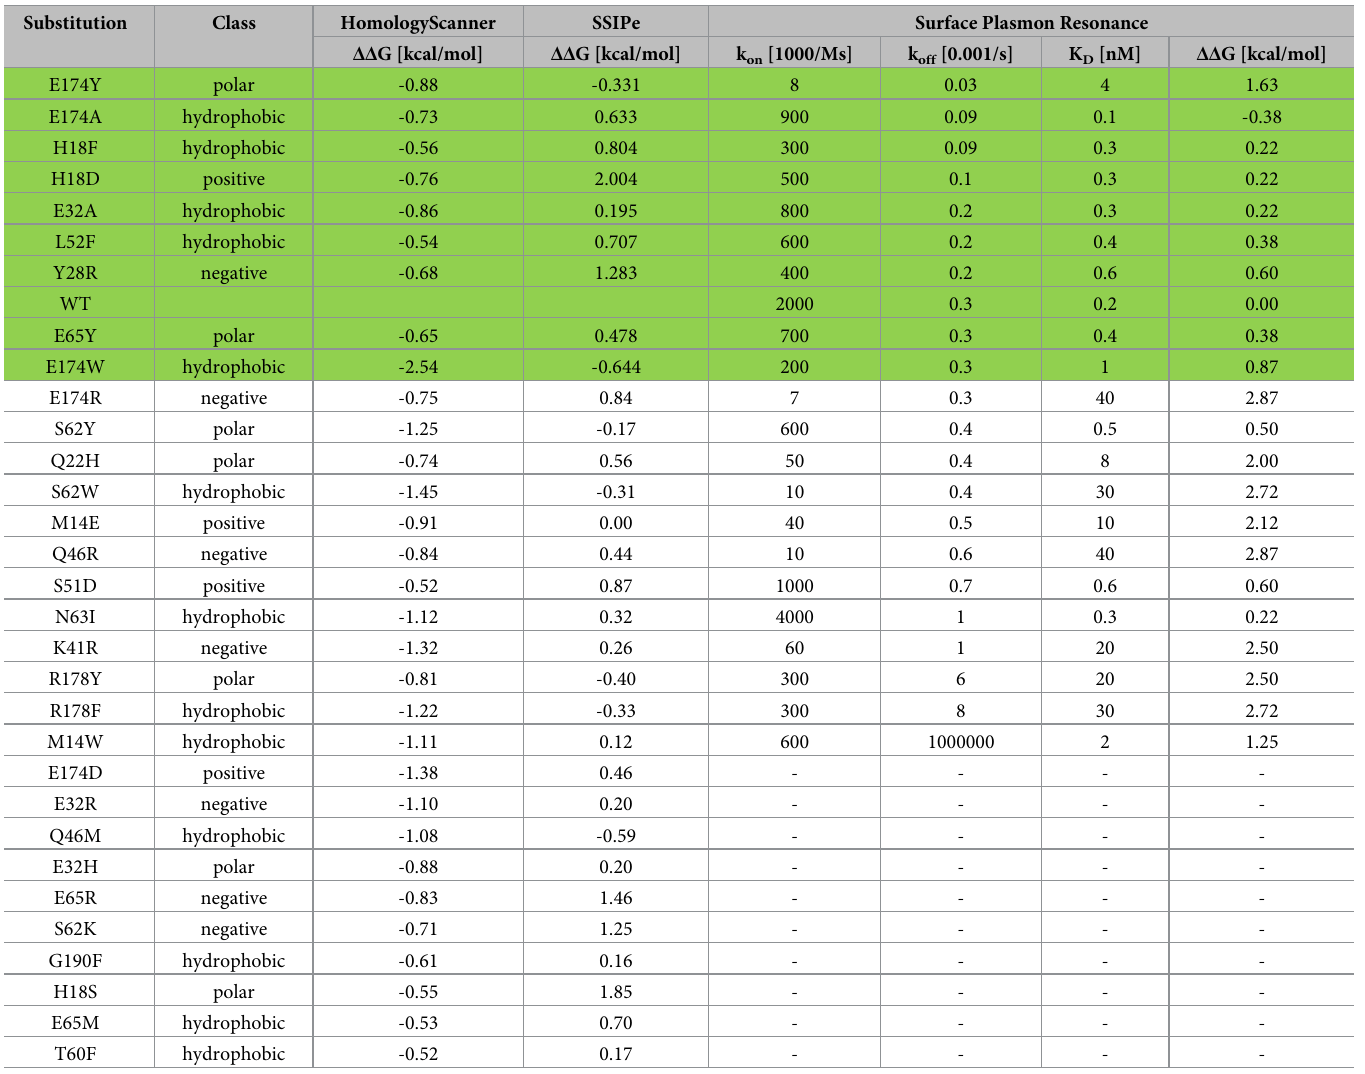
Table 1. rhGH/ hGHR Binding energy predicted by HomologyScanner and SSIPe, and kinetics of binding measured by Surface Plasmon Resonance, ordered by k off . Green shading indicates K D comparable to that of WT. ΔΔ G experimental .was computed based on the measured K D and T = 273K. In these cases, k on is also slower than WT, such that the only E174A has K D lower than that of WT. The Pearson correlation between ΔΔ G homologyScanner and ΔΔ G experimental was -0,18, and that between ΔΔ G SSIPe and ΔΔ G experimental was -0,40. This had no particular significance, with p-values of 0,4 and 0,07, respectively, by two-tailed